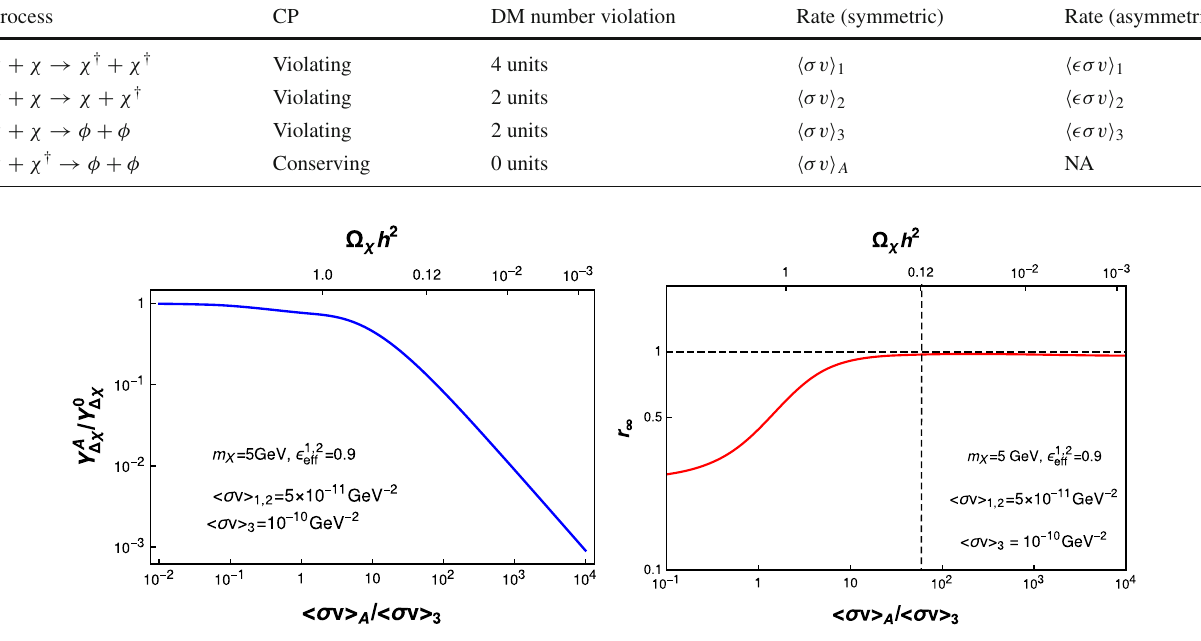
Fig. 3 Left panel: the ratio, Y A (cid:15)χ / Y 0 (cid:15)χ , where Y A (cid:15)χ and Y 0 (cid:15)χ are the asymptoticvaluesoftheyield Y (cid:15)χ ,withandwithouttheCP-conserving annihilation process, respectively, as a function of (cid:9) σv (cid:10) A / (cid:9) σv (cid:10) 3 . Also shown are the corresponding values of the DM relic abundance (cid:16) χ h 2